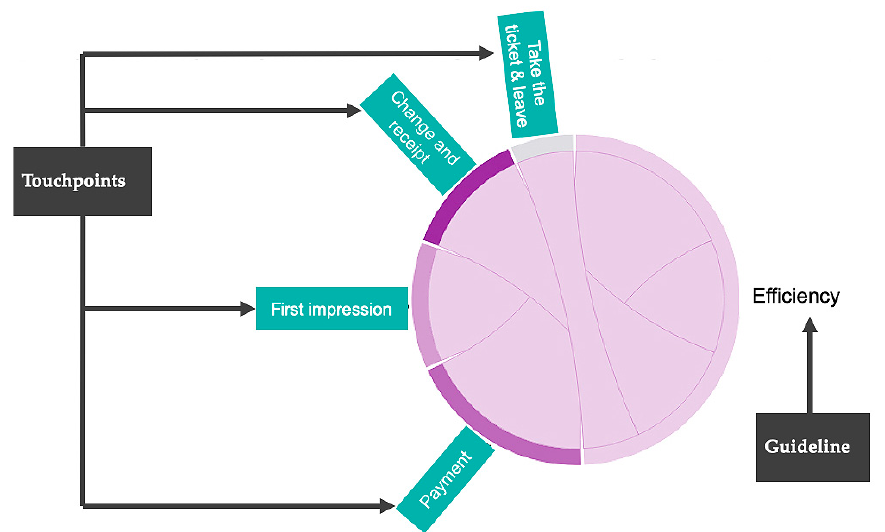
Figure 17. Screenshot of a chord diagram showing the relationship between efficiency guideline and the touchpoints of the automated parking machines in Cali.